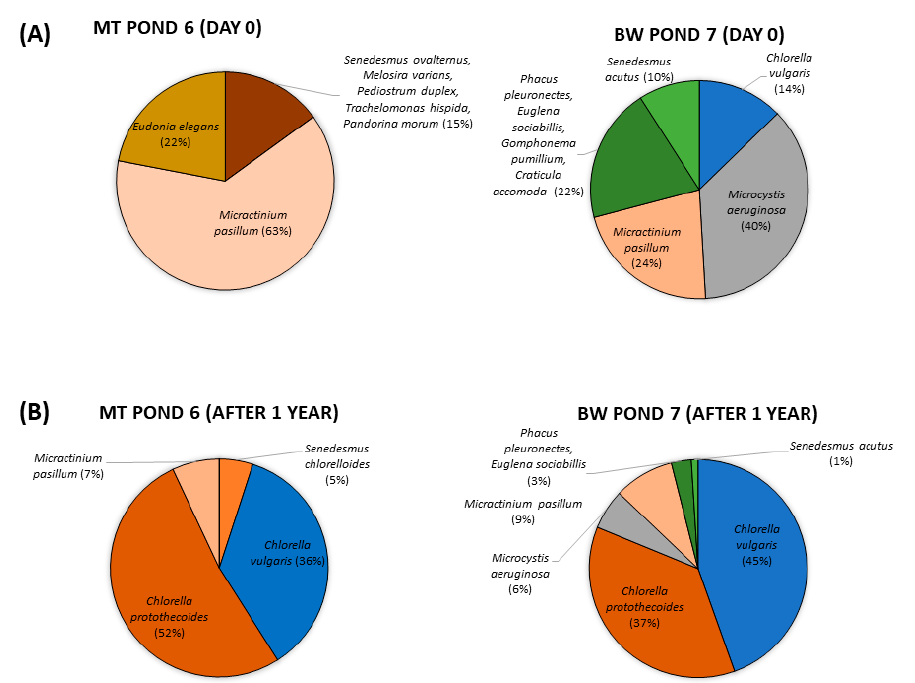
Figure 5. ( A ) Distribution of natural algae species in the last maturation pond before mass inoculation of the consortium of specific microalgae species (day 0) at the Motetema (MT) and Brandwag (BW) municipality WWTP systems. ( B ) Distribution of algae species in the last maturation pond 1 year after inoculation of the consortium of specific microalgae species at the Motetema (MT) and Brandwag (BW) municipality WWTP